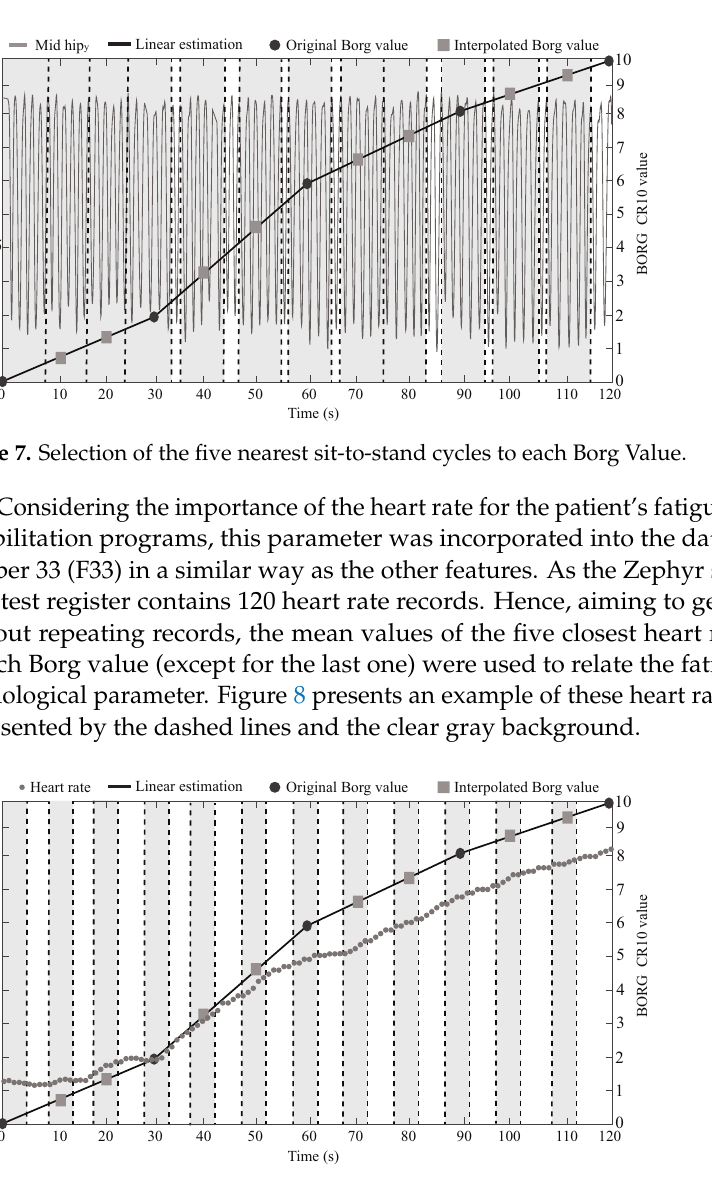
Figure 8. Selection of the five nearest heart rate records to each Borg value. Therefore, at the end of this process, the interpolated and original Borg values are related to the average of the corresponding 32 kinematic/temporal features (F1 to F32) and the average heart rate